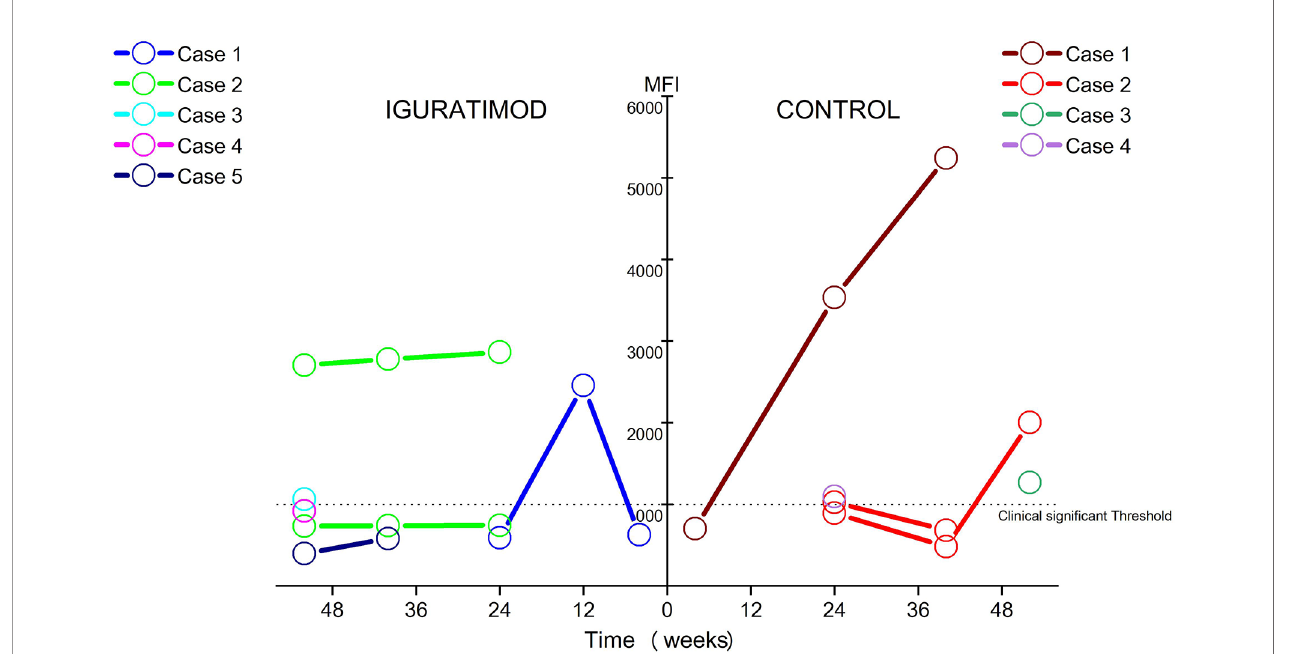
FIGURE 4 | Ebb and fl ow of de novo DSA during follow-up in two groups. Only DSAs with MFI ≥ 500 were detectable DSA and MFI ≥ 1000 were considered clinically signi fi cant. In Iguratimod arm, 5 patients developed 6 detectable DSA, only 2 patients (case #2 and case #3) remain clinically signi fi cant DSA at last follow- up, with case #3 just borderline. In contrast, 4 patients developed 5 detectable DSA, and 3 of them (case #1, case #2, and case #3) sustained to be clinically signi fi cant at the last follow-up, especially with two cases (case #1 and case #2) growing fast in the control group. No statistical difference of DSA incidence was found between two arms (14.8% in the control and 19.2% in the IGU, c 2 test: P = 0.95). The average MFI for all clinically signi fi cant DSA at the last examination was 2048.8 in control group, while 1203.0 in IGU group ( P =